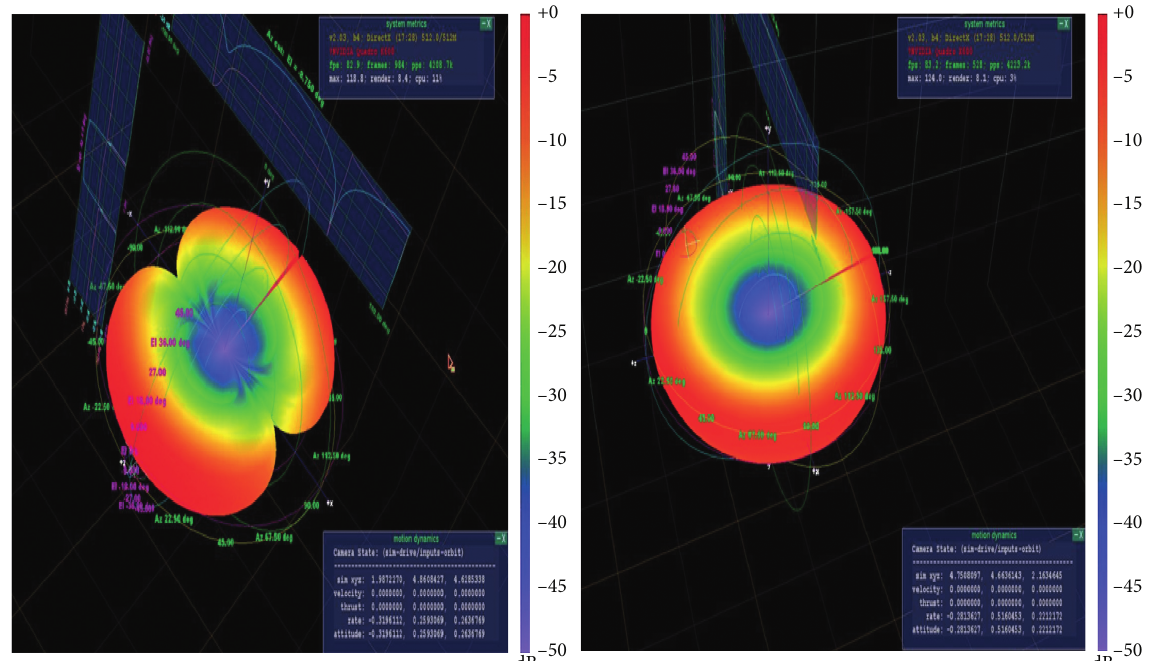
Figure 7: 3D plots for the electric field radiation pattern measurement at 458MHz inside an anechoic chamber considering the FR4-G10 substrate and corresponding to VD (left) and HD (right).